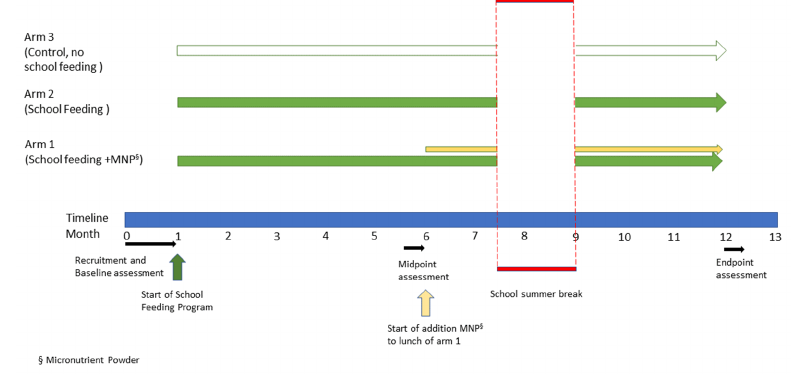
Figure 1. Overview of the study design and timeline.